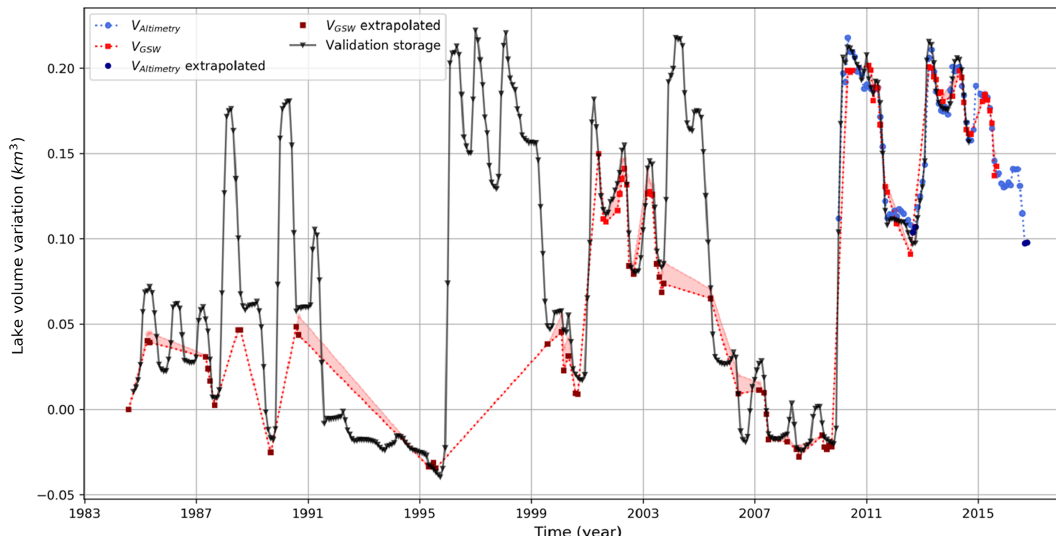
Figure 11. Time series of satellite-estimated volume variations compared to validation storages for Puente Nuevo Reservoir.